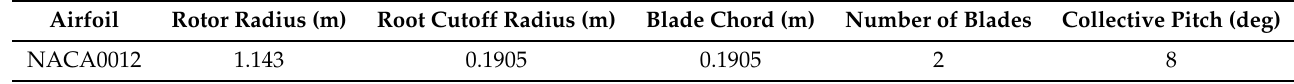
Table 4. Geometric parameters of the propeller model